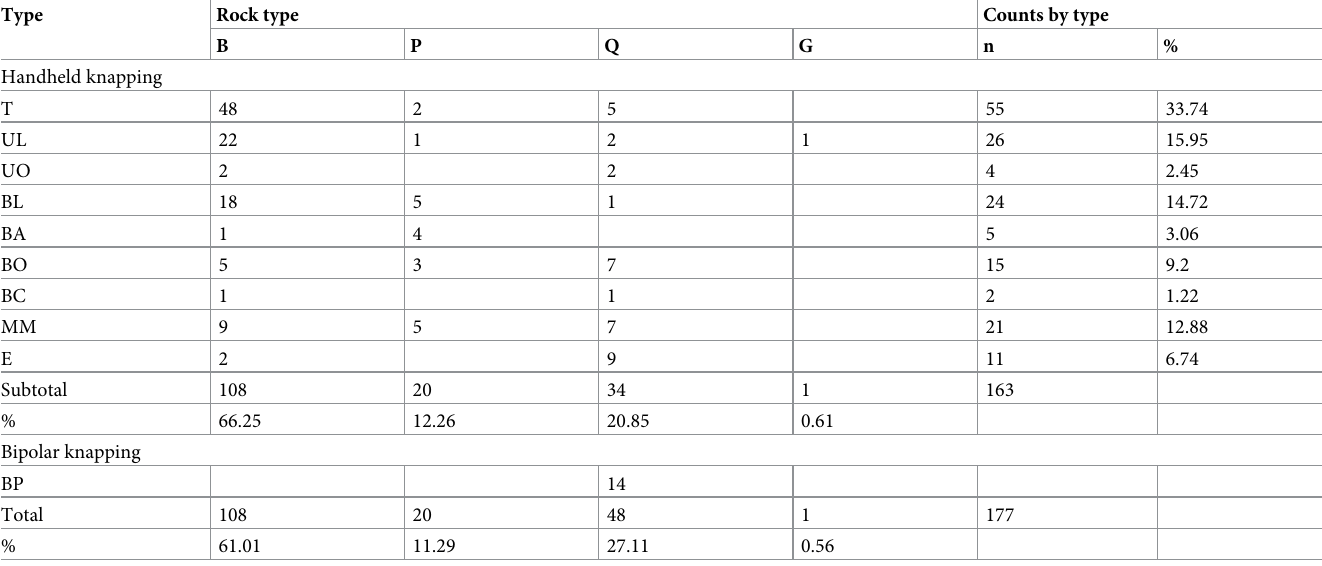
Table 2. Distribution (number and percentage) of cores sorted by technique, reduction model and rock